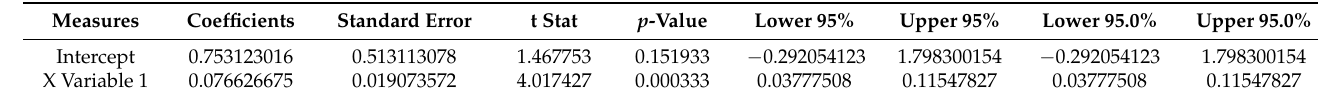
Table 8. p -Value